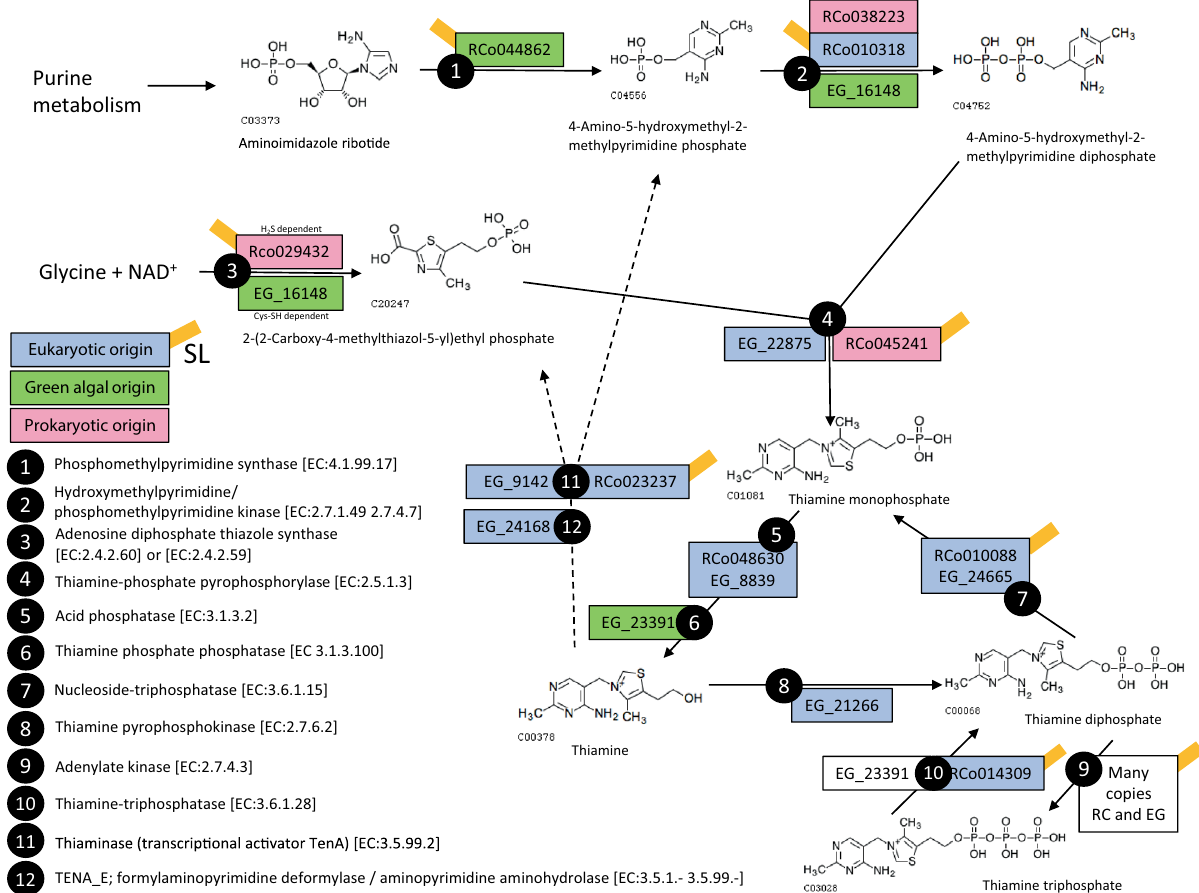
Figure 6. Map of the thiamine metabolism of R. costata . The enzymes identified in the transcriptome of R. costata are indicated in rectangles above or to the right from the arrows (opposite from their E. gracilis homologues). The colour scheme indicates the phylogenetic origin of these enzymes and the presence of SL longer than nine nucleotides is marked by orange rectangles. The pathway map and compound drawings are based on KEGG 23